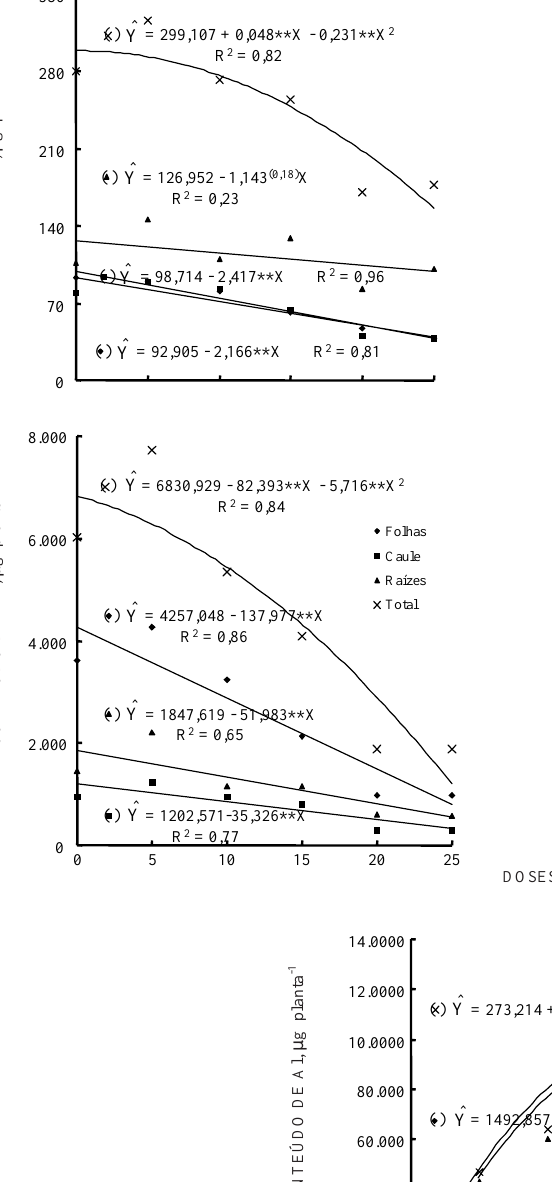
Figura 3. Teores de micronutrientes e alumínio nas folhas, caule, raízes e total nas mudas de goiabeira de acordo com com as doses de alumínio (* e ** significativos a 5 e 1% e os valores entre parênteses representam a significância dos coeficientes de regressão não significativos nem a 5%).